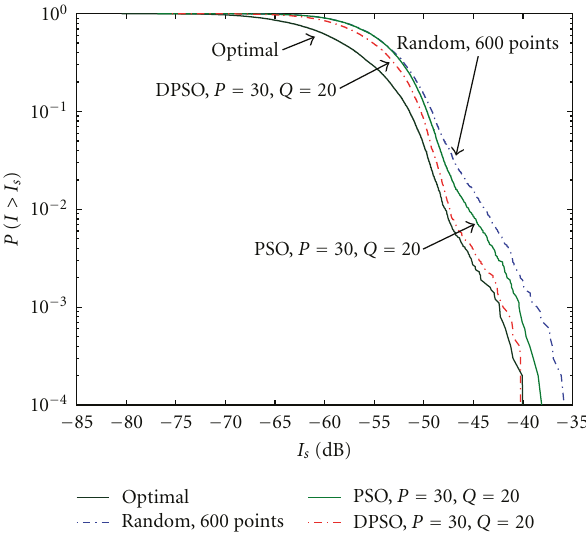
Table 1: Complexity of optimal, PSO/DPSO PTS-AIC.